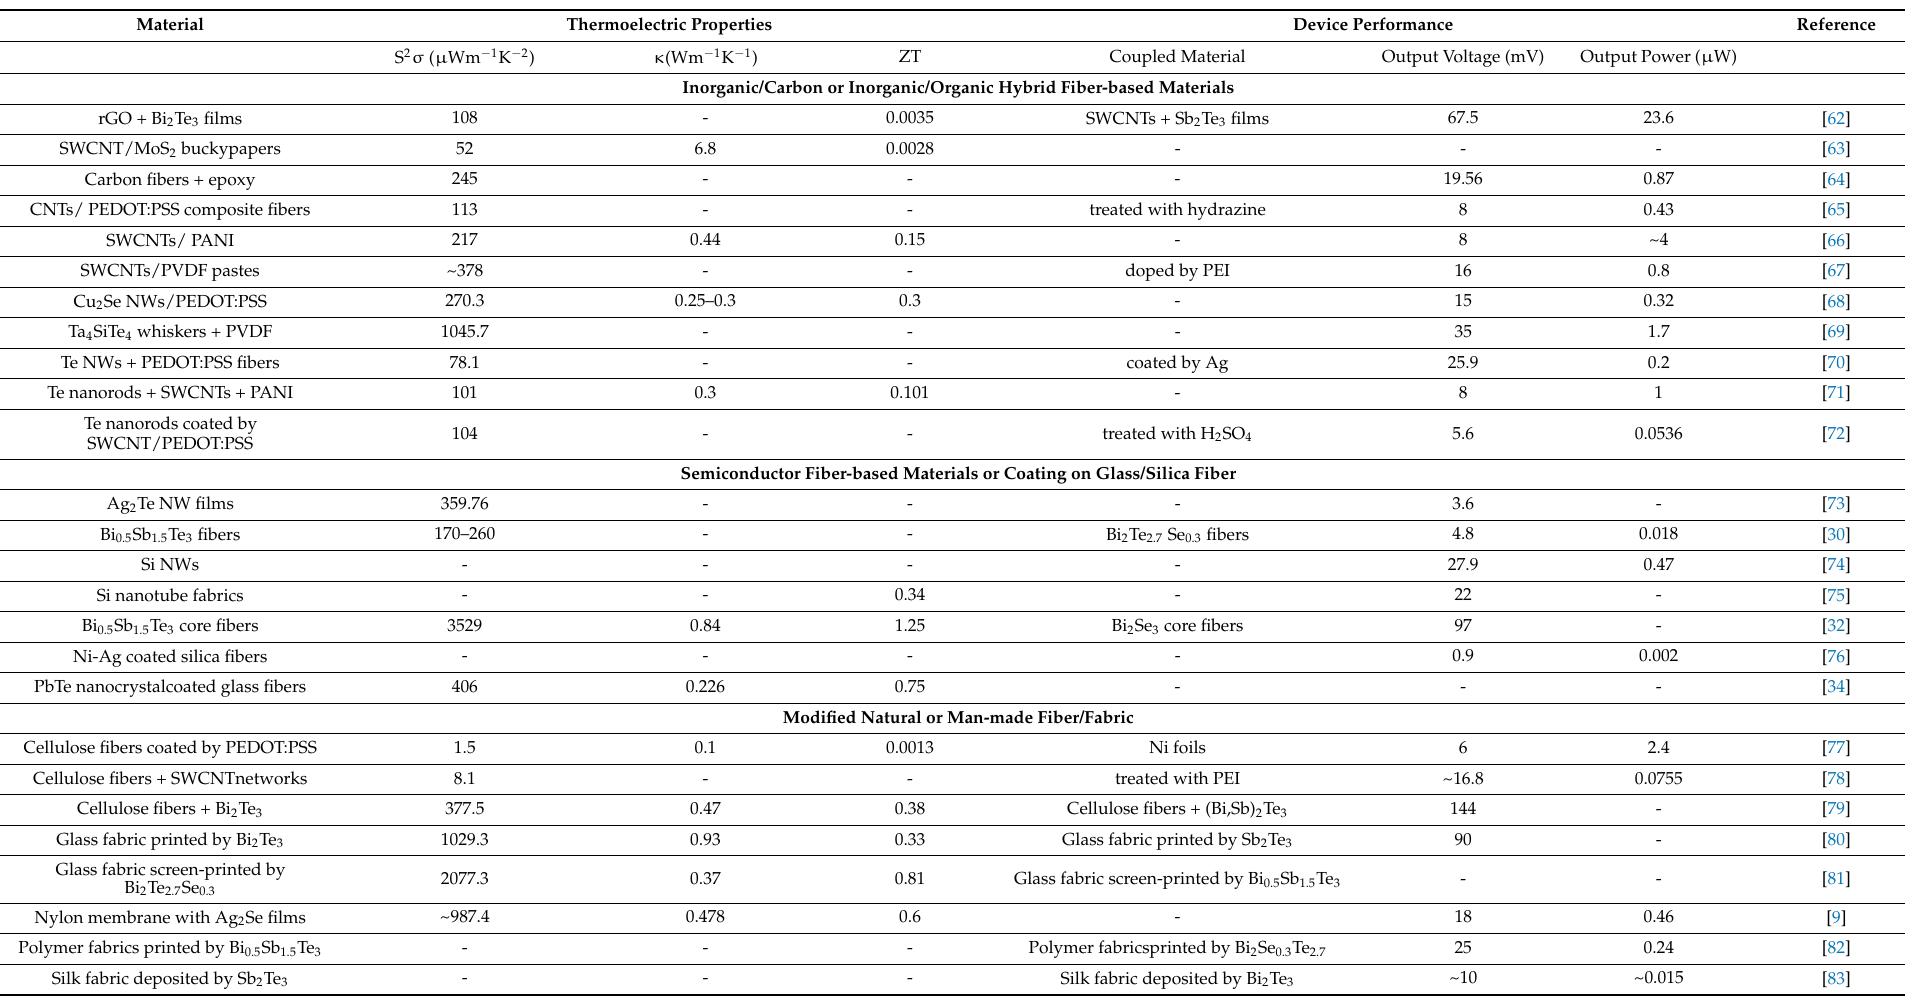
Table 1. A comparison of thermoelectric properties/device performance between different shapes (fibers, film, nanorods, fabrics, etc.) and various techniques detailed by inorganic/organic hybrid fibers, semiconductor fibers or coating on glass/silica fiber, and modified natural or manmade fiber/fabric of thermoelectric